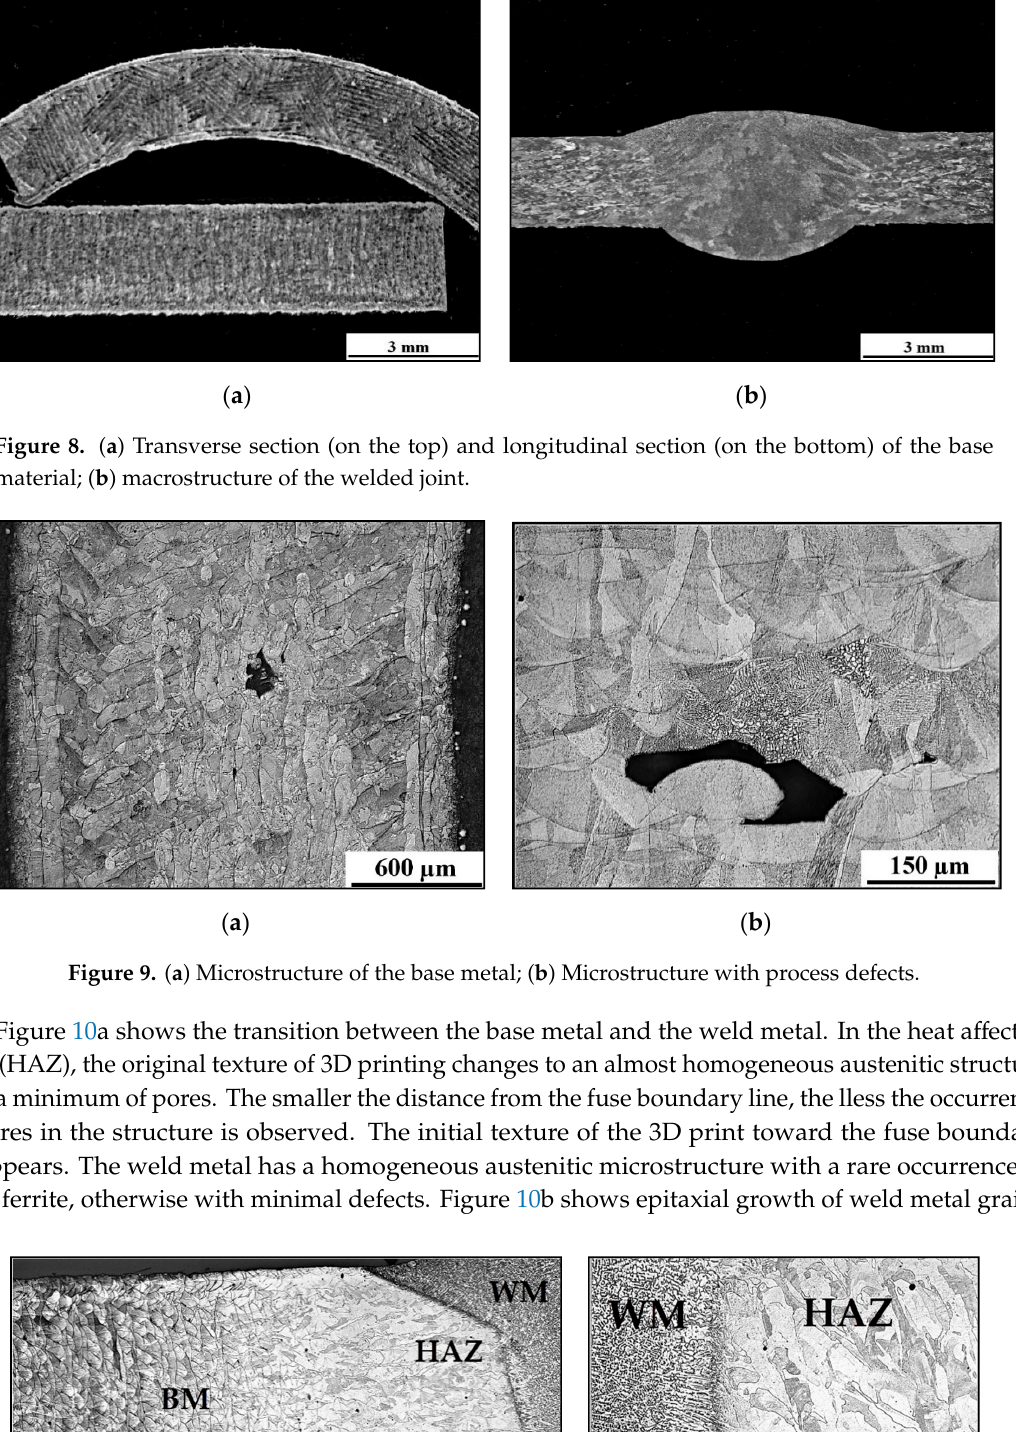
Figure 10. ( a ) Transition between base metal (BM) and weld metal (WM); ( b ) epitaxial growth of weld metal